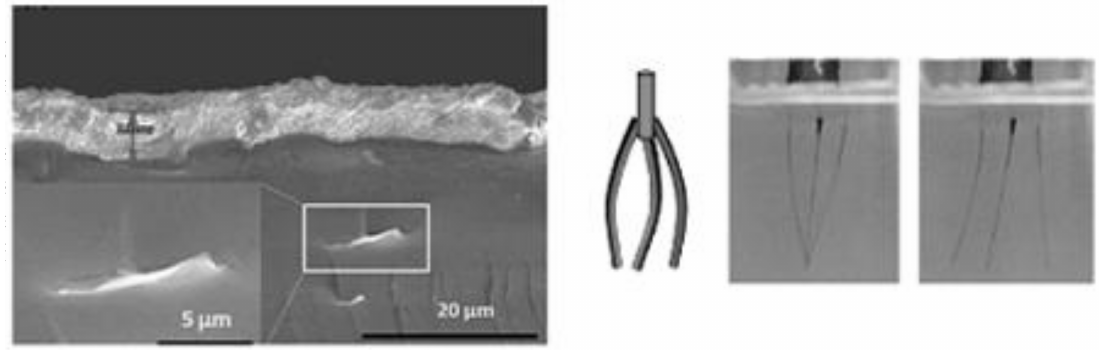
Figure 5. ( Left ) Graphene–Nafion membrane (thickness ~0.34 mm) from [95] and ( right ) snapshots of the tri-armed tweezers made by graphene fiber / polypyrrole (GF / PPy) driven by an applied electrical potential from